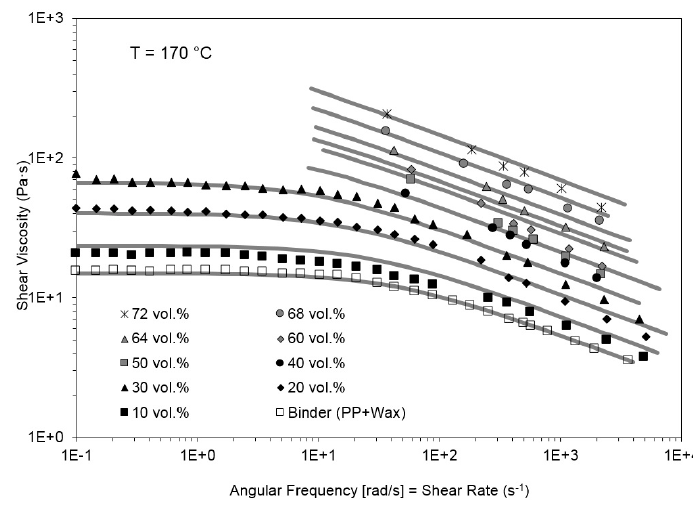
Figure 4. Viscosity of PP-based feedstock materials with different powder content [41]. Solid line represents the fitting by Carreau model. © Christian Kukla (Montanuniversitaet Leoben). Figure first published by EPMA in the Euro PM2014 Proceedings.